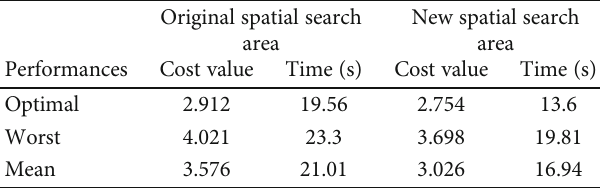
Table 7: Results comparison for two spatial search areas. Original spatial